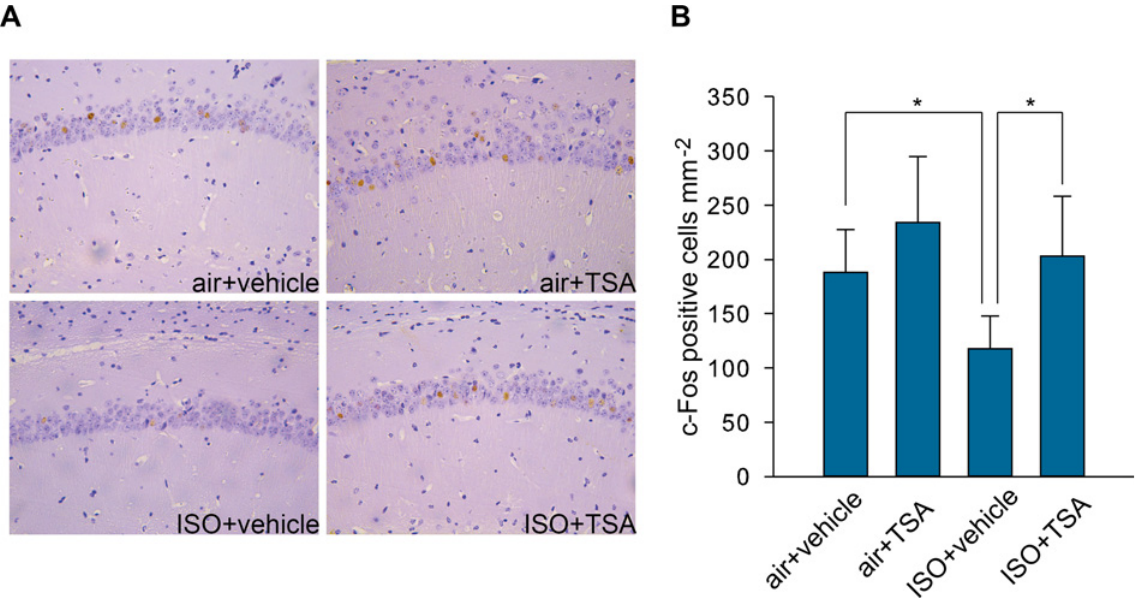
Fig 4. TSA injection improved c-Fos expression in response to CFC training in mice that received repeated neonatal exposures to isoflurane. (A) Representative immunohistochemistry images of c-Fos in the CA1 hippocampal region 1 h after CFC training. Hippocampal neuronal nuclei were stained purple with hematoxylin, and nuclear c-Fos protein is stained brown by DAB. (B) c-Fos-positive cell counts. Mice that received repeated neonatal exposures to isoflurane showed reduced numbers of c-Fos-positive neurons in the CA1 hippocampal region 1 h after CFC training, but this decrease was rescued by systemic TSA administration. * p < 0.05. Mean (SD) values are